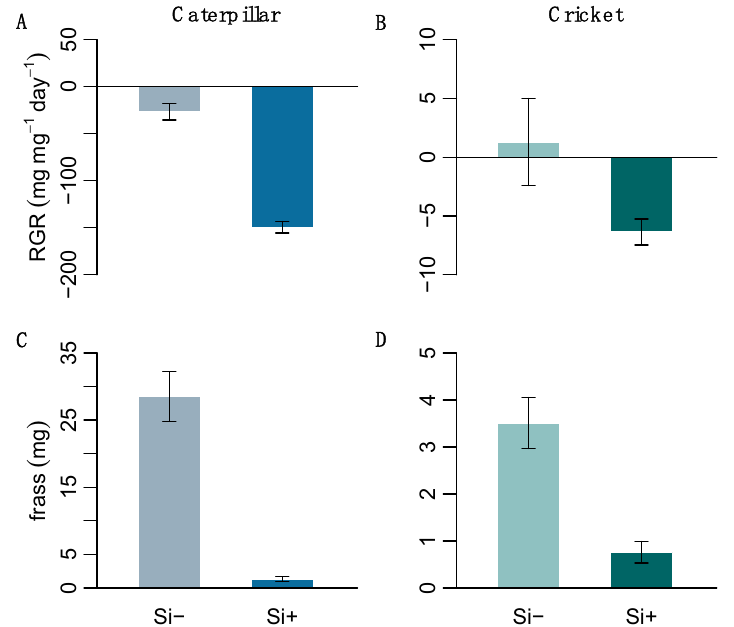
Figure 4. The relative growth rate of ( A ) H. armigera and ( B ) A. domesticus and their frass ( C , D ), respectively, after feeding on Si+ and Si- B. distachyon ( n = 12). Values are means ± SE.